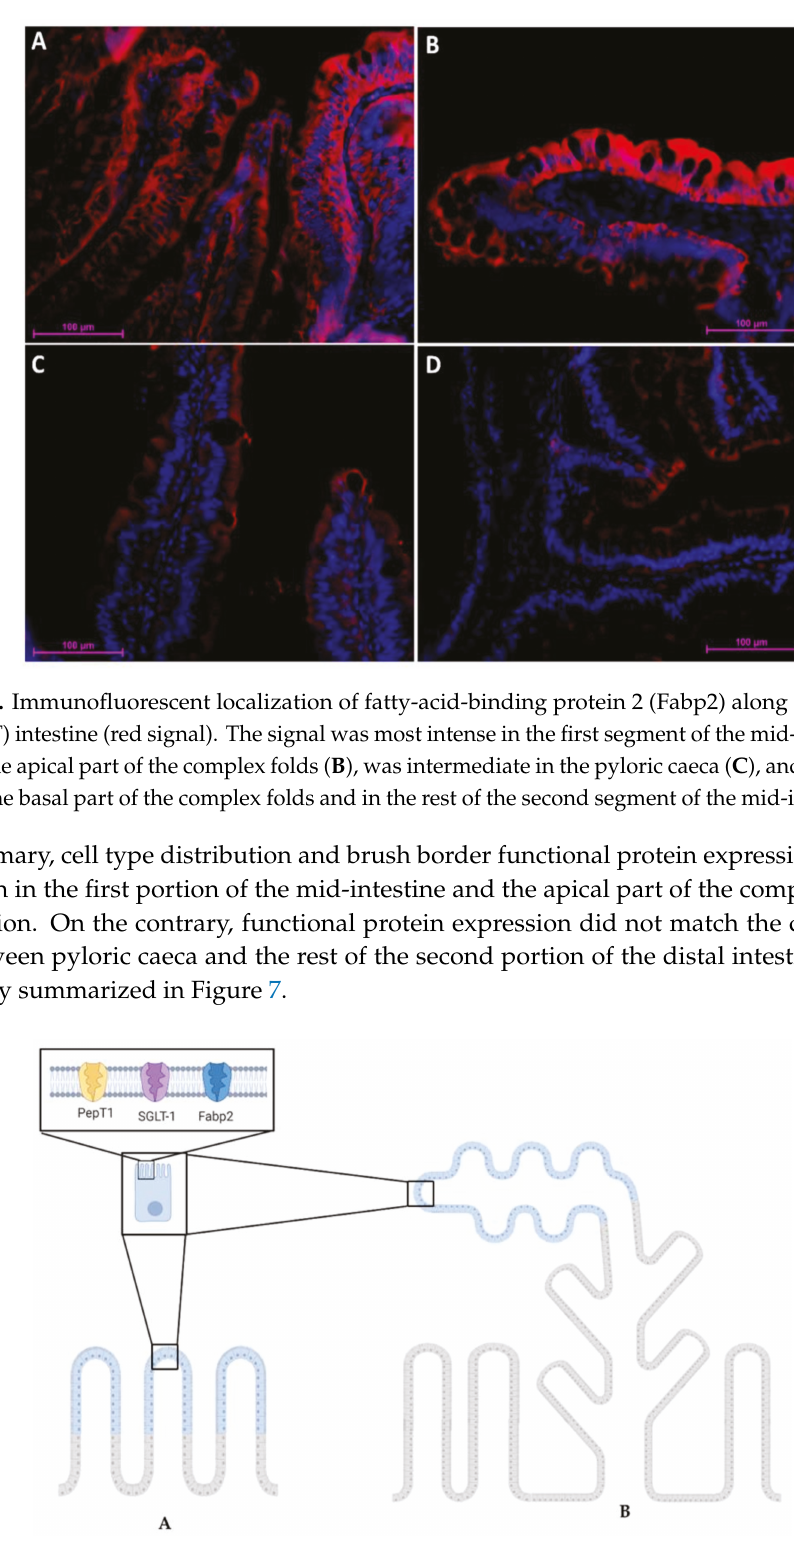
Figure 7. The cartoon highlights the common PepT1, SGLT-1, and Fabp2 expression pattern between the first segment of the mid-intestine ( A ) and the second segment of the mid-intestine ( B ). Illustrations created with BioRender.com.